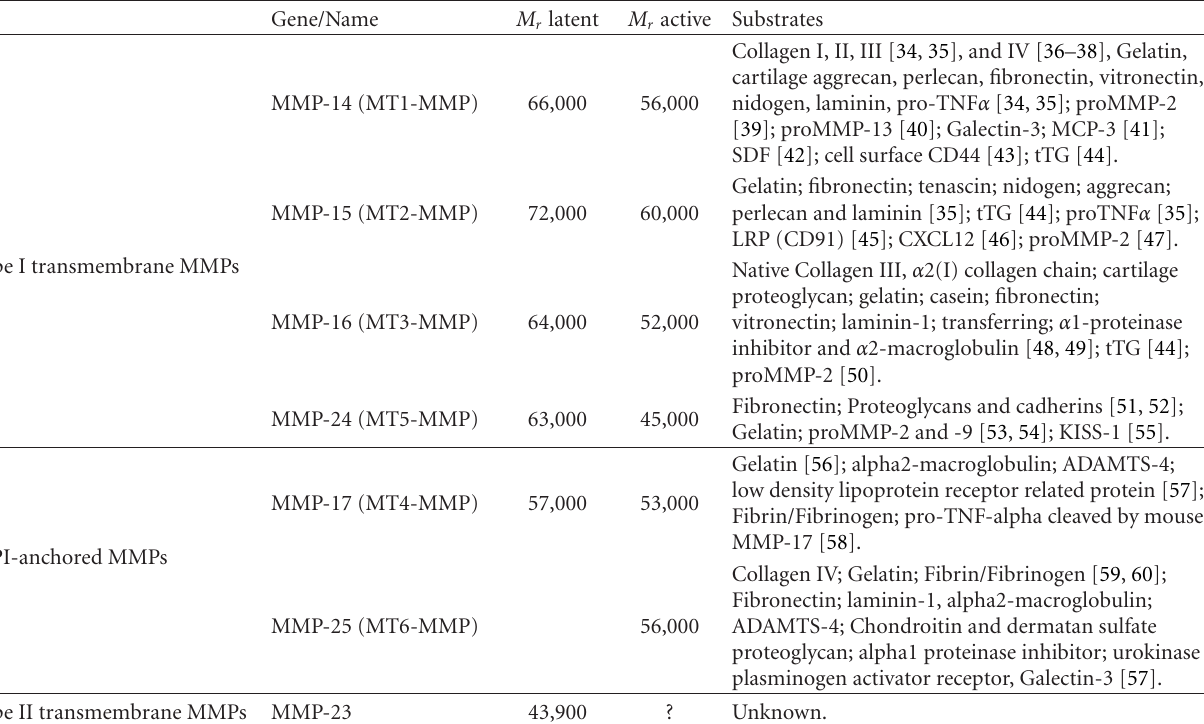
Table 1: Substrates for membrane-bound MMPs.